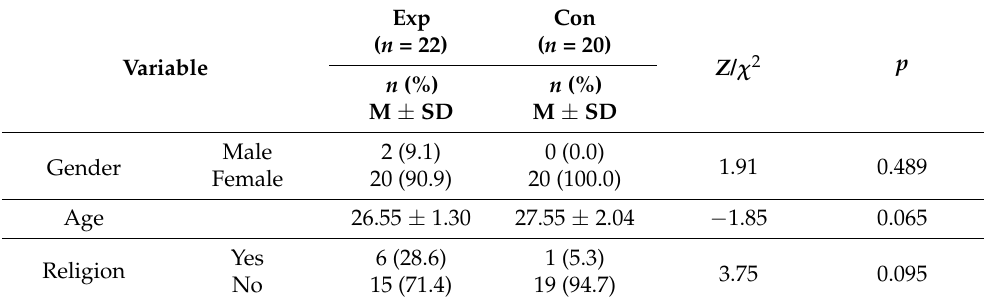
Table 2. Participants’ general characteristics and homogeneity